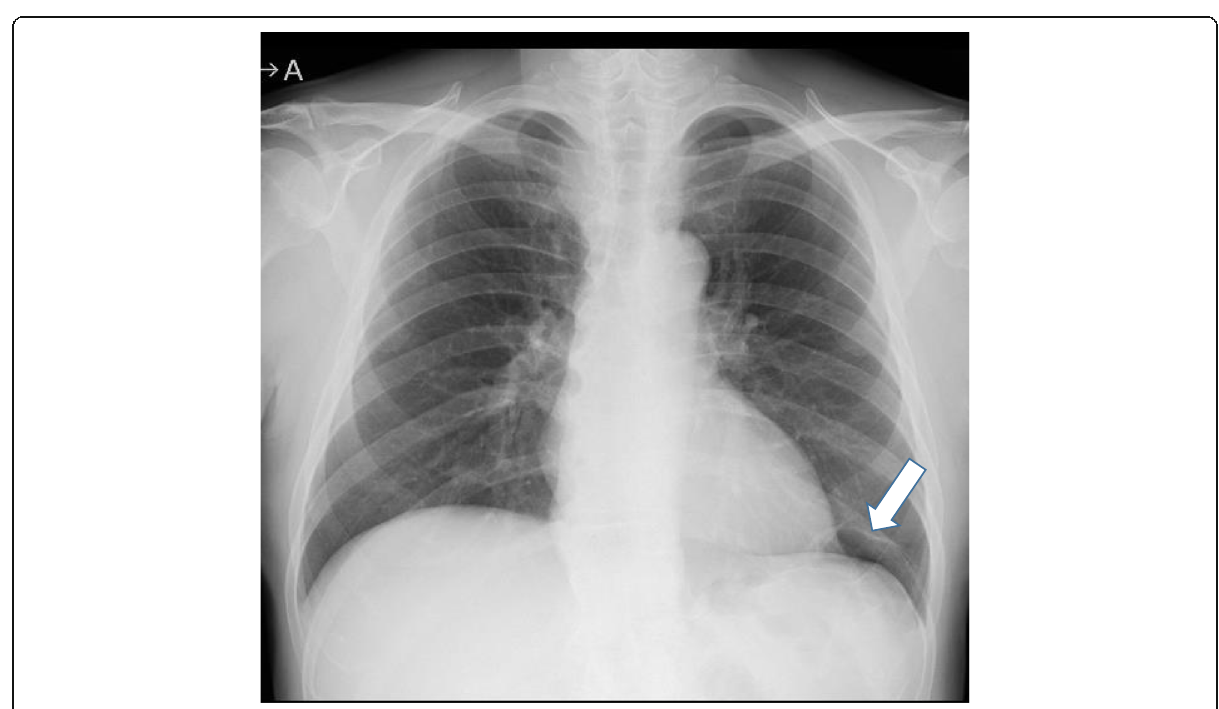
Fig. 1 A chest radiograph showed a linear shadow in the left lower lung field